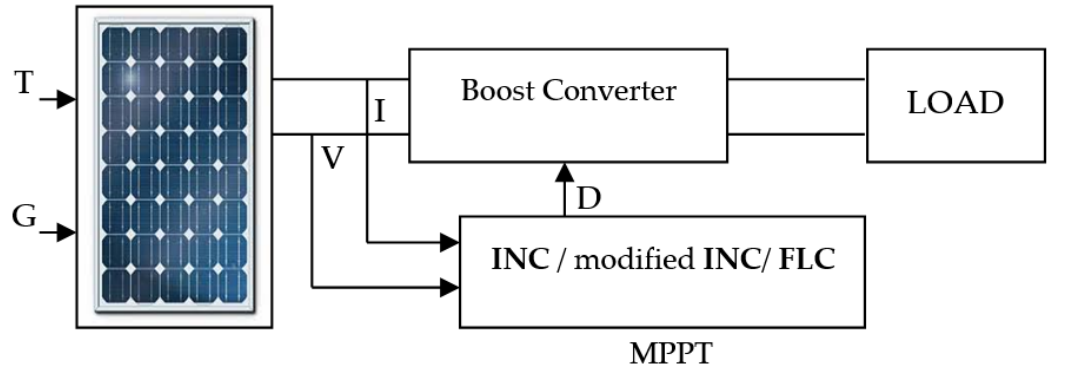
Figure 1. Block diagram of the proposed PV system.